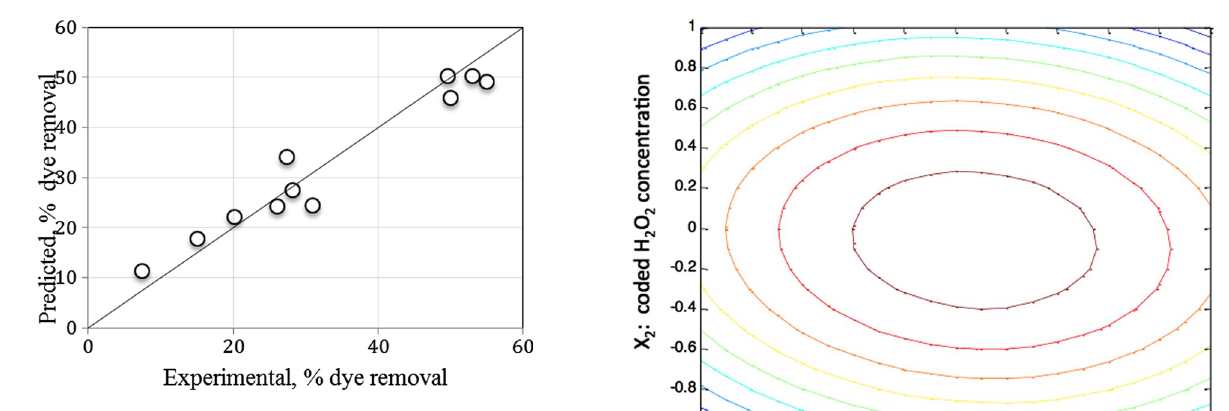
Fig. 2 Box–Behnken design plot for predicted versus actual values for dye removal